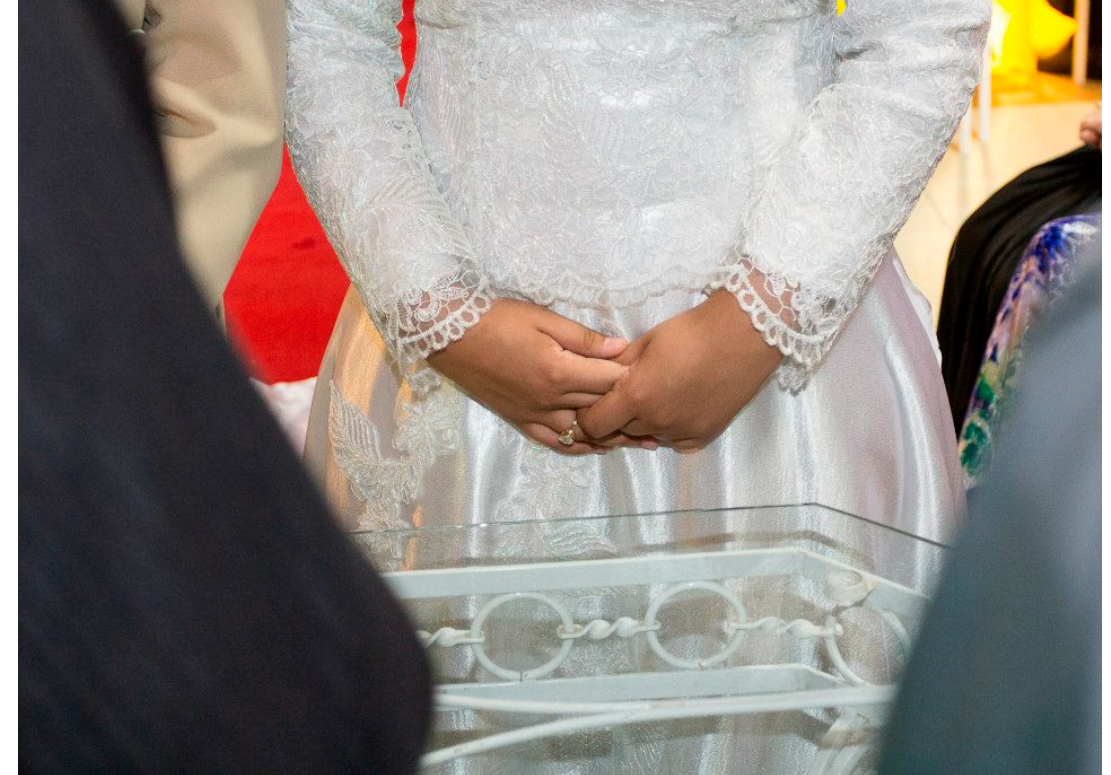
Figure 2. Details of the wedding dress. Photography courtesy of Petra Duarte.